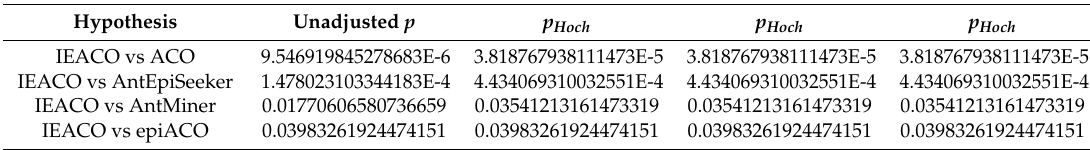
Table 6. Adjusted p -values on 5000-SNP datasets.